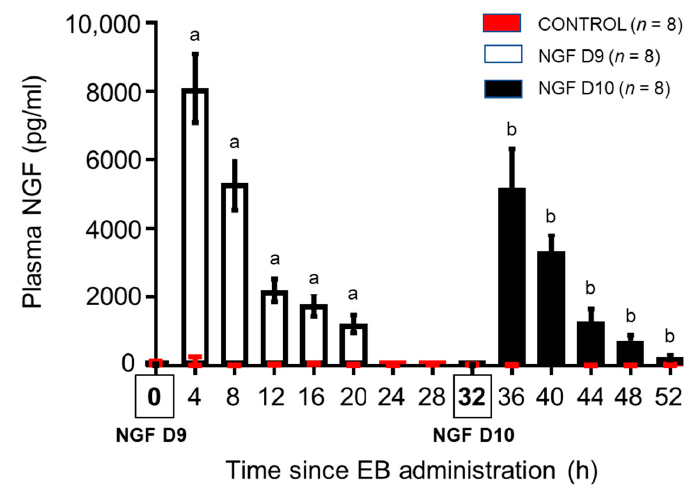
Figure 2. Kinetics of plasma NGF in estrus-synchronized heifers treated with PBS (control), NGF D9, or NGF D10. Data are centralized to the day of second EB administration. Values are mean ± SEM; different superscripts indicate post hoc significant differences between corresponding time points of NGF-treated groups at p < 0.05.